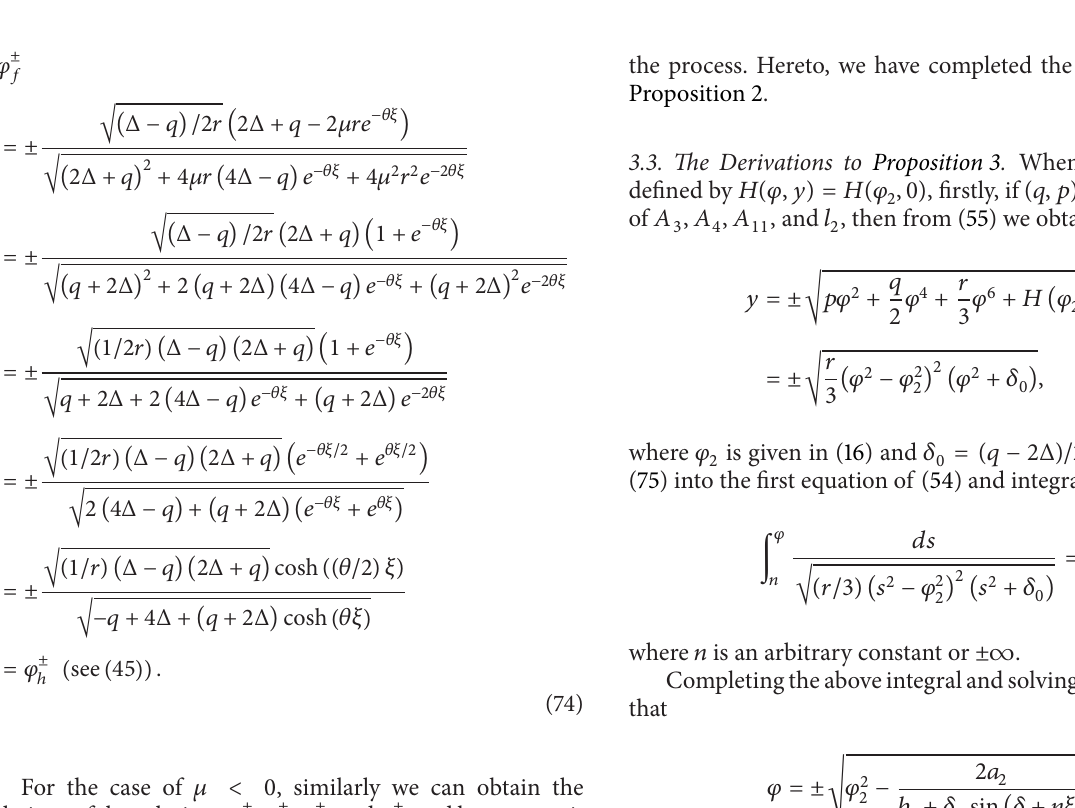
Figure 13: (The 1-blow-up waves are bifurcated from the periodic blow-up waves.) The varying process for the figures of 𝜑 ± 𝑗 when (𝑞,𝑝) ∈ 𝐴 4 and 𝑝 → 𝑞 2 /4𝑟 − 0 , where 𝑟 = 1 , 𝑞 = −4, and 𝑙 1 : 𝑝 = 𝑞 2 /4𝑟 = 4 and (a) 𝑝 = 4 − 10 −1 , (b) 𝑝 = 4 − 10 −2 , (c) 𝑝 = 4 − 10 −4 , and (d) 𝑝 = 4 − 10 −6 .